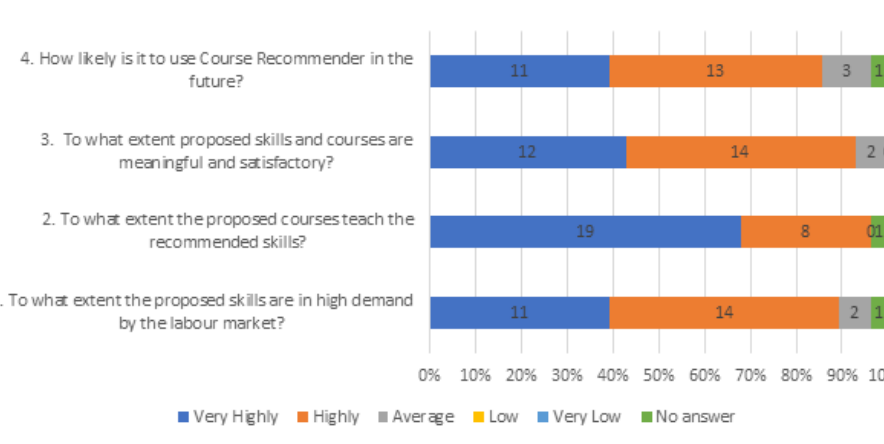
Figure 15. Course Recommender evaluation by university students.